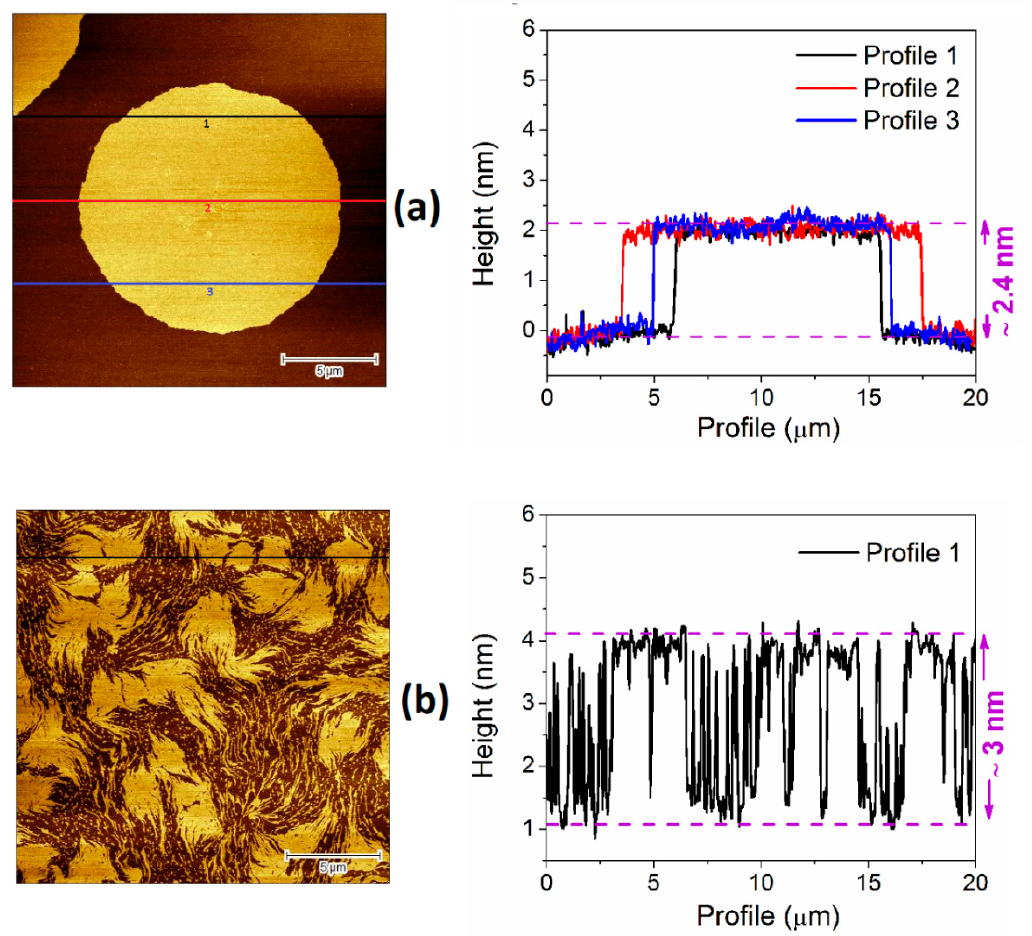
Figure 5. AFM height images (left) with the line profiles (right) of the LB film transferred at a π of 10 mN / m for ( a ) Ethoxy-PPE mN / m and ( b ) Methyl-PPE- co -decadiene. The image size is 20 × 20 µ m 2 . Enlarged AFM images of Methyl-PPE- co -decadiene can be found in Figure S8 of the supporting information.